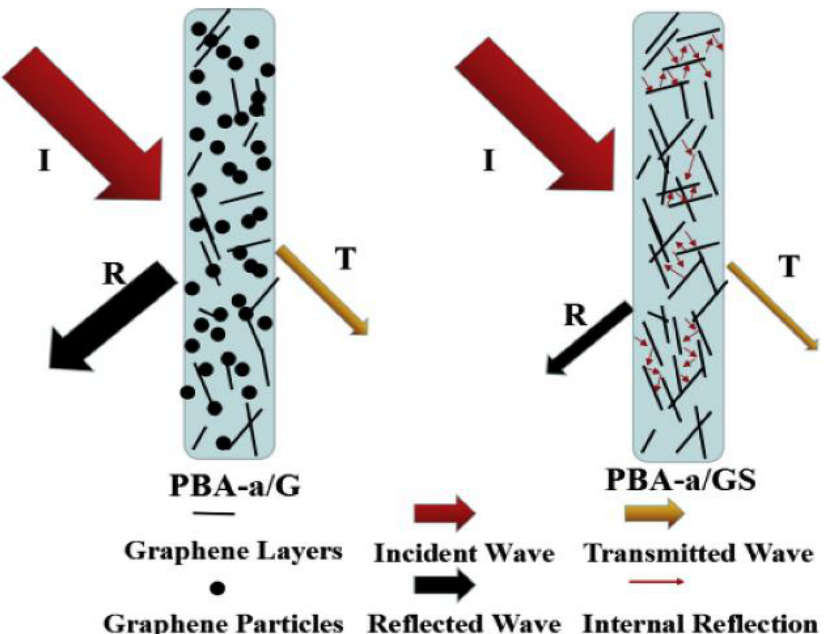
Figure 53. Schematic of EMI shielding of polybenzoxazine/graphene nanocomposite samples PBA- a/G and PBA-a/GS (reproduced from the work in [121] with permission).